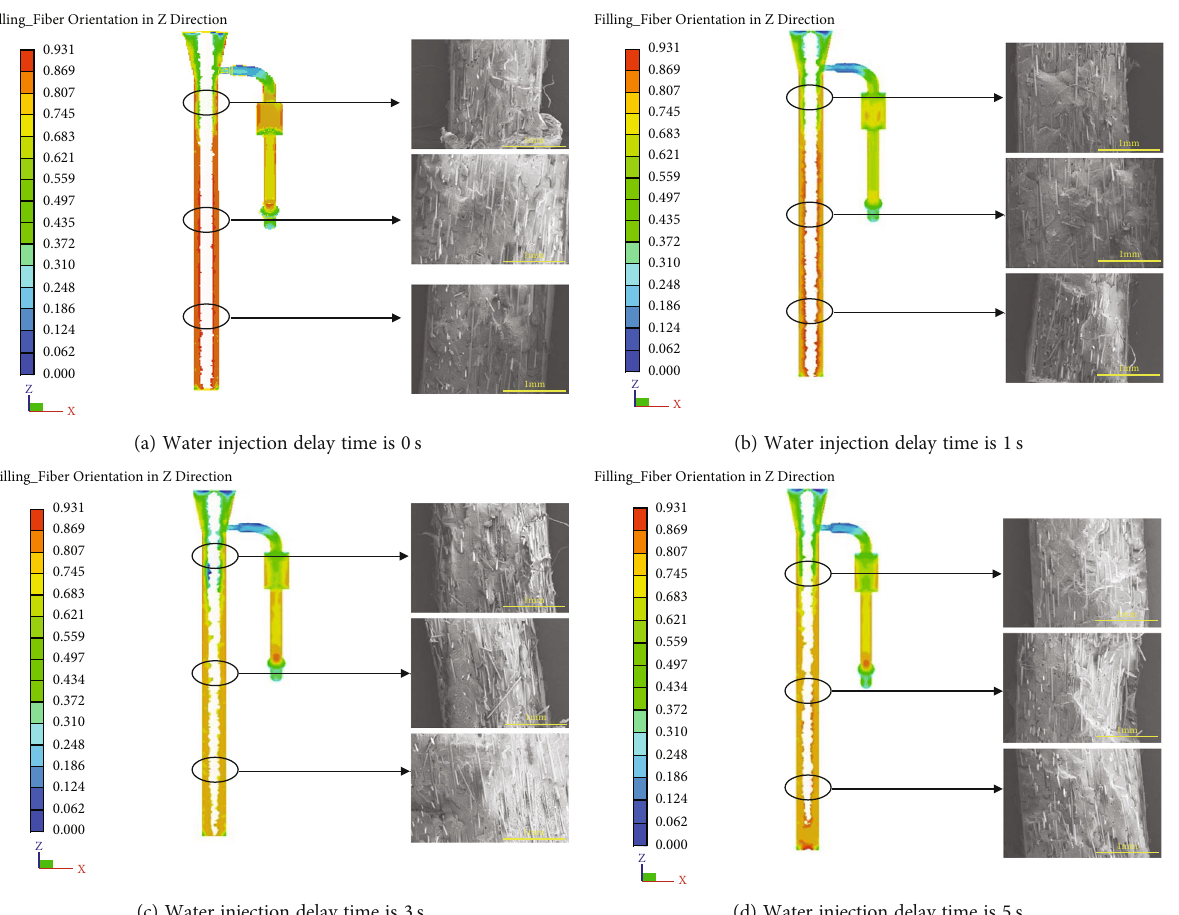
Figure 5: Fiber orientation distribution along the fl ow direction at di ff erent water injection delay